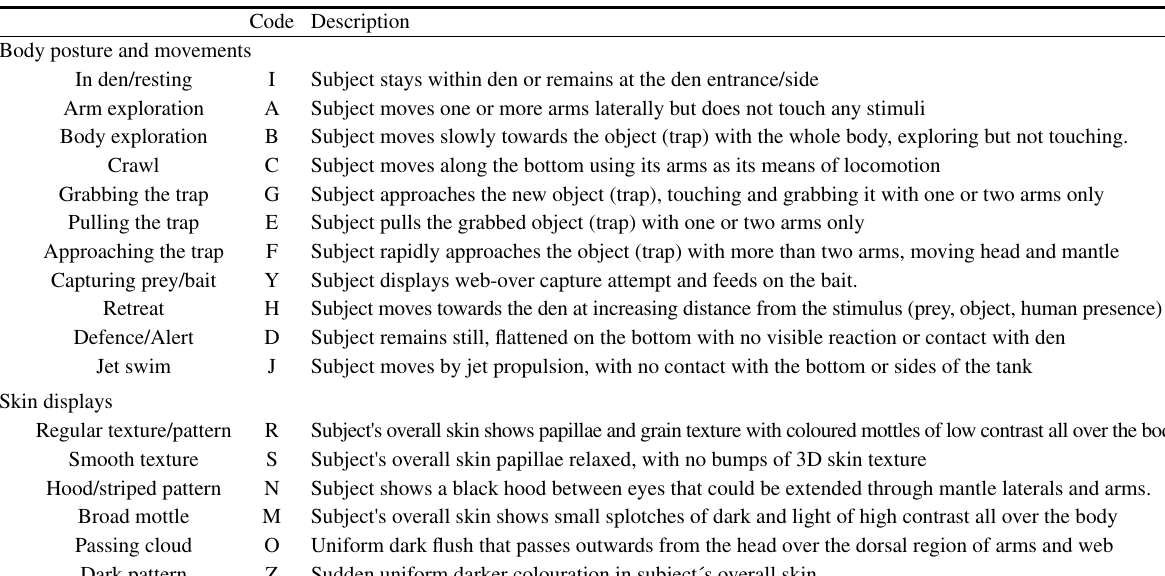
Table 1. – Ethogram of body patterns (i.e. body posture, movements and skin displays) exhibited by O. vulgaris during experimental tests facing a baited trap (=